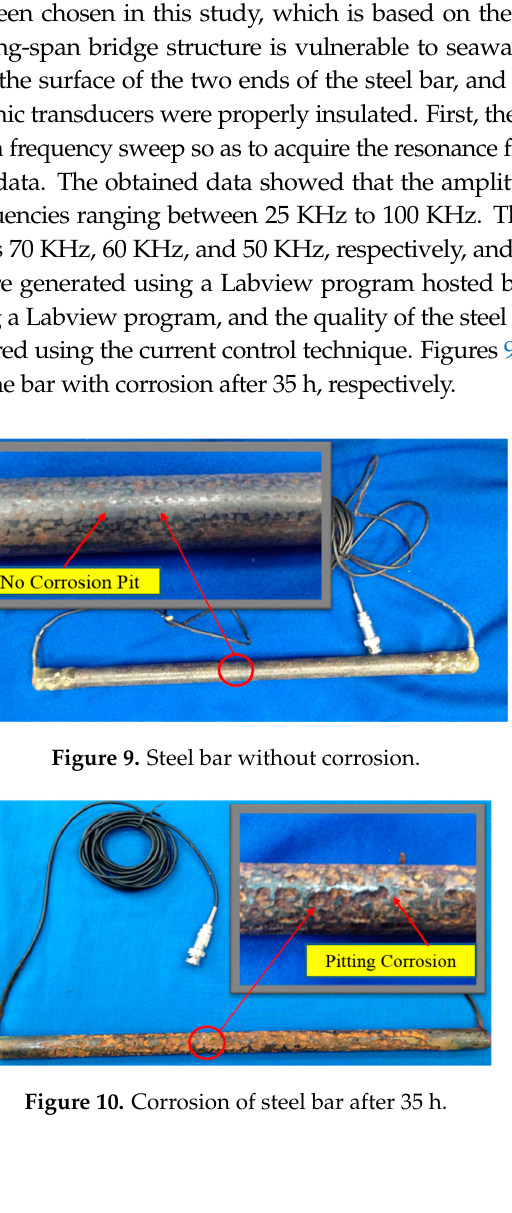
Figure 10. Corrosion of steel bar after 35 h.